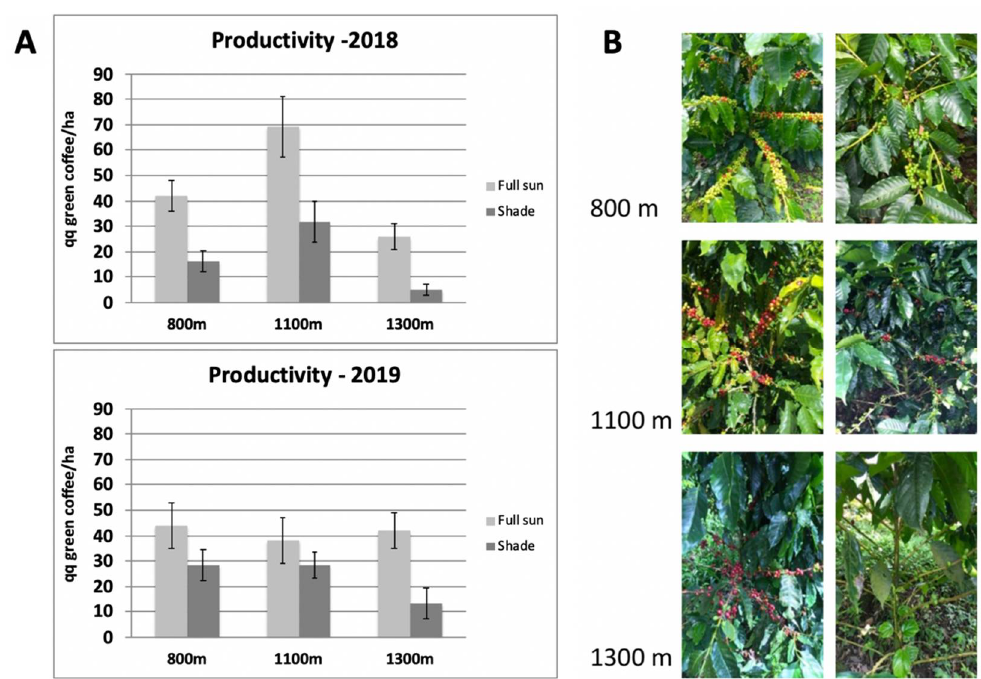
Figure 2. Biennial variations in production depending on the elevation and shading of the Arabica cv. Marsellesa. ( A ) Yield comparison of trees grown in full sun and under shade at three elevations. We studied three plots in Nicaragua planted with the modern variety Marsellesa. Marsellesa plants were planted in three crop fields in 2014 at three different elevations in the “La Cumplida” farm (Matagalpa, Nicaragua). The “Santa Fe” field is located at 800 m elevation (12°59’59’’N, 85°52’8’’O), the “El Coyol” field is located at 1100 m elevation (13°1’5’’N, 85°51’6’’O) and the “El Panorama” field is located at 1300 m elevation (13°1’1’’N, 85°50’32’’O). Each field is divided into two parts, one of which is in full sun all day. The second corresponds to an agroforestry system with a high shading level of above 50%. Yield was measured in quintals of green coffee per hectare. Yield was estimated over two growing seasons (2018—2019). This assessment was based on 25 trees per condition, counting the number of cherries per six branches at three heights representative of the tree. The average was then multiplied by the number of productive branches to obtain the number of cherries per tree. In order to assess the standard error of this method, the exact number of cherries was counted for several trees. The standard error was thus estimated at +/− 10%. The same evaluation method was used to estimate the number of flowers per tree. ( B ) Representative pictures of fruit load of trees grown in full sun or under shade at three elevations.